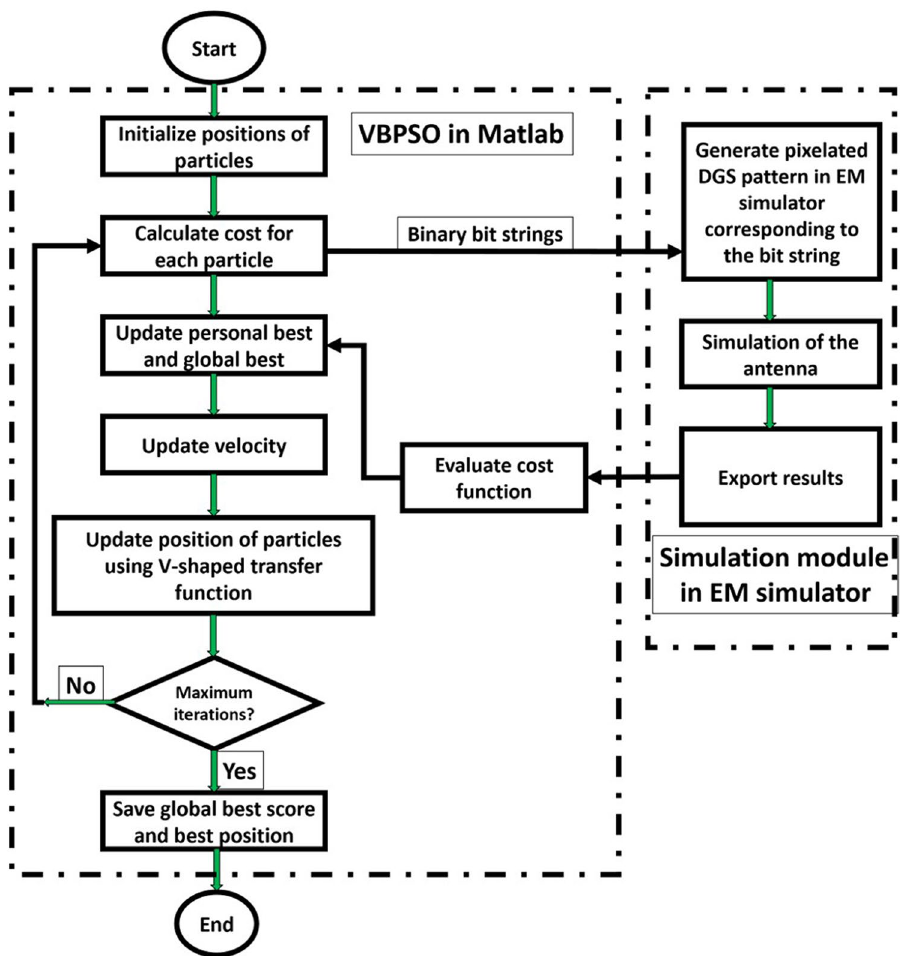
Figure 5. Proposed PDG Antenna design